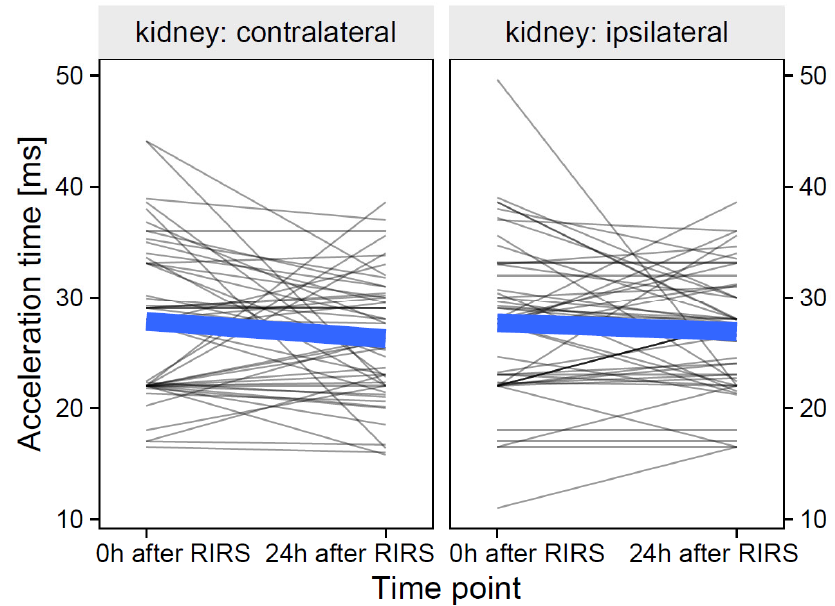
Figure 12. The effect of kidney side on the pulsatility index over time (the thin, semitransparent black lines in the background are the individual-level data. The bold blue lines in the foreground are the group averages). The figure shows that the effects of the kidney side on the acceleration time focal variable were slightly different over time. The inclusion of the effects of mean stone volume, energy used, pre-stenting, and kidney side at separate time points is presented in Sections 3.2.3.1–3.2.3.3.